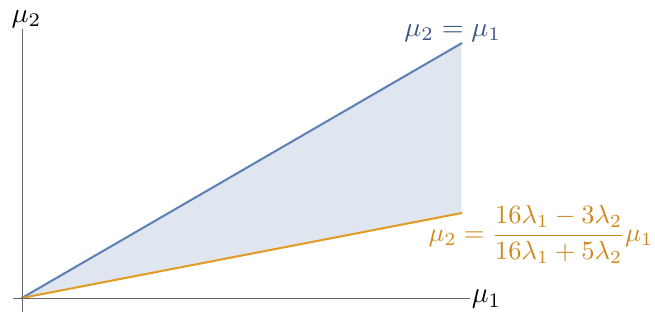
Figure 1 . The shaded region indicates the possible values of the chemical potentials (cid:22) parametrizing the time-dependence of the classical ground state, eq. (3.5), in the (cid:12)rst Weyl chamber. The Noether